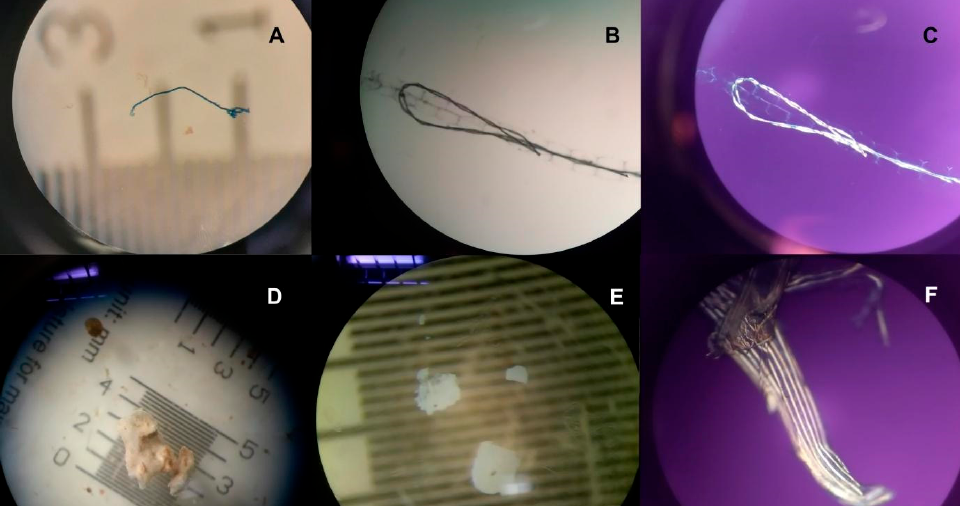
Figure 3. Variety of fibers ( A – C ) and fragments ( D – F ) recovered from digestions of digestive tract contents of fish. C and F show the reaction of the items to exposure to polarized light (optical active).